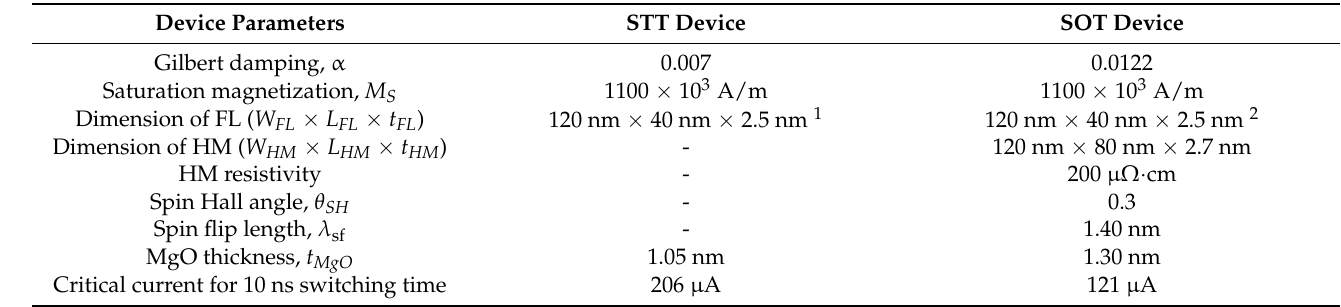
Table 1. Parameters of storage devices.